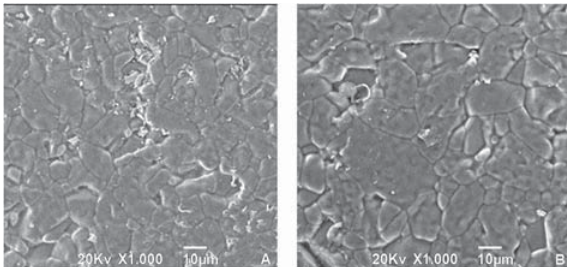
Figure 4- Scanning electron microscopy micrograph showing surface topography of TMA wire (associated with MB) before (A) and after (B) mechanical traction